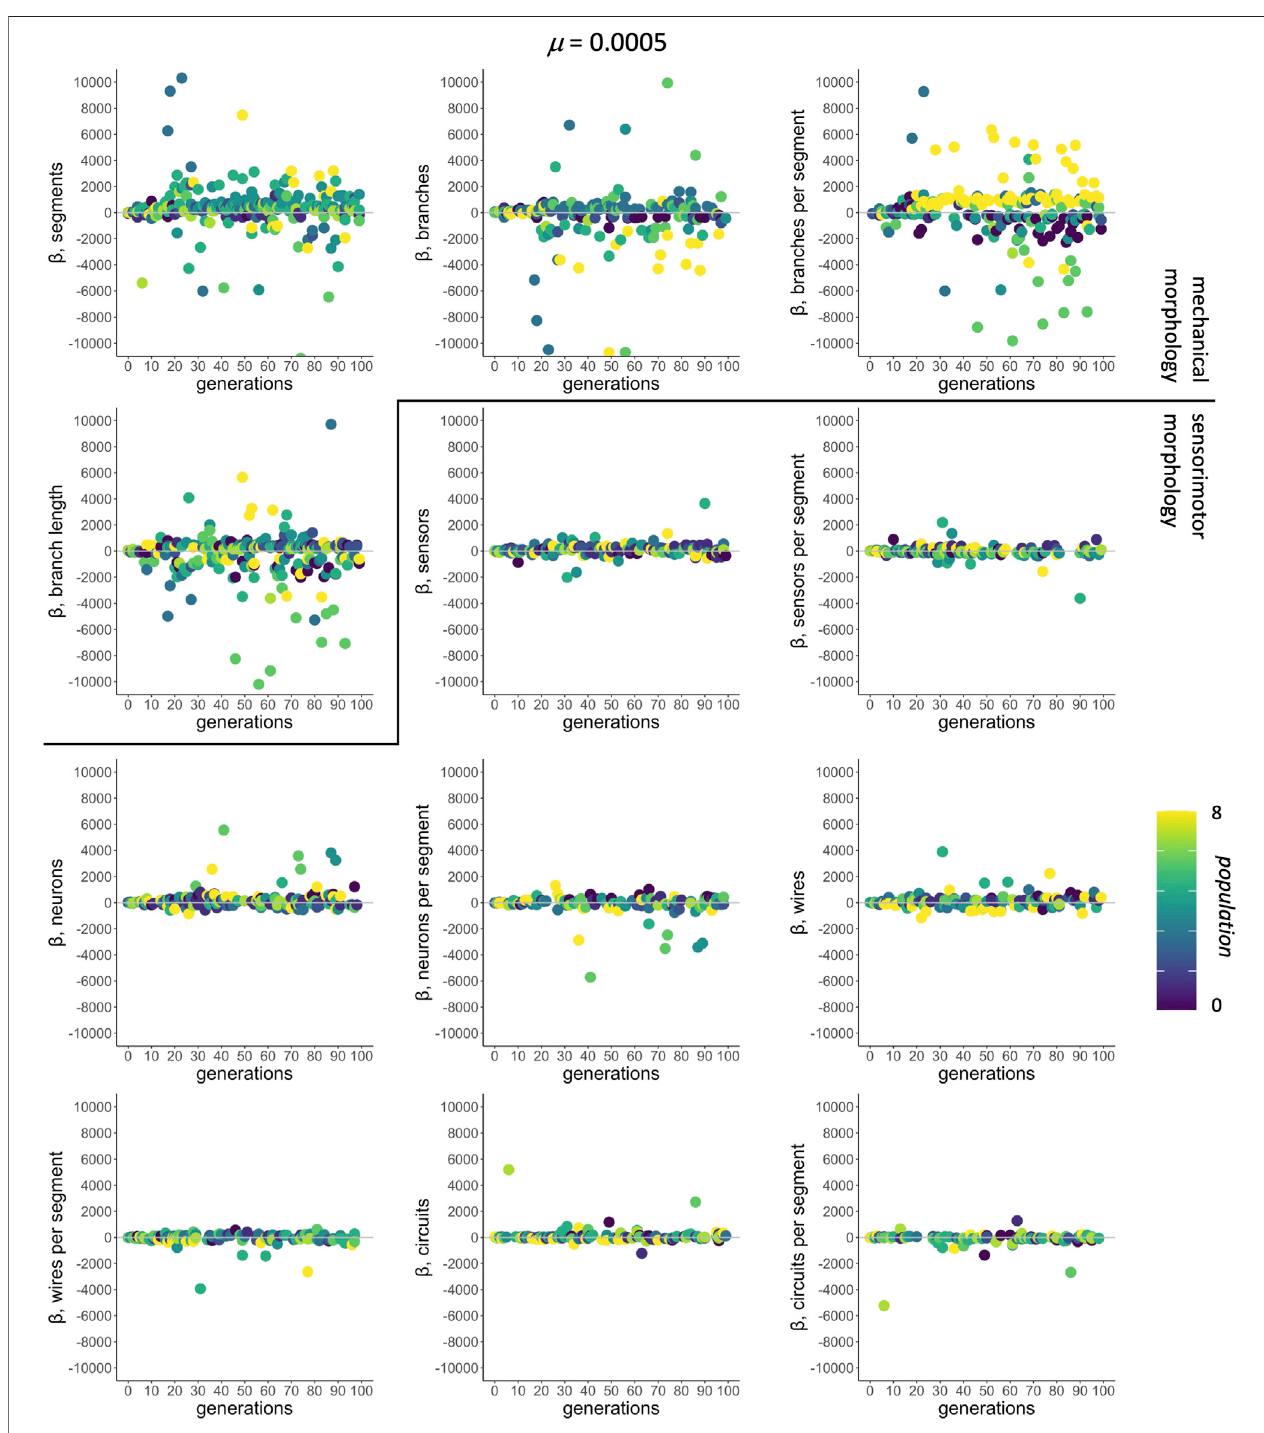
FIGURE 6 | Selection gradient analysis: morphological targets. The subset of signi fi cant mean-standardized directional selection gradients chosen by AIC from all 12 traits are shown by population (different shades). The mutation condition μ (cid:1) 0 . 0005 is shown here because it evolves the populations with the highest mean fi tness (see Figure 4 ); we see similar trends at other non-zero levels of mutation.